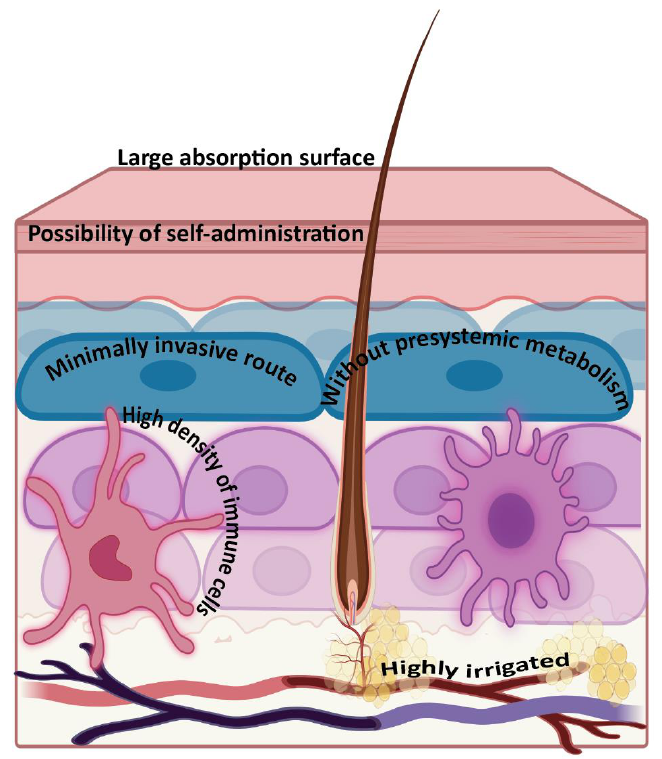
Figure 2. Advantages of transdermal vaccine delivery. Created with BioRender.com (accessed on 27 October 2021).